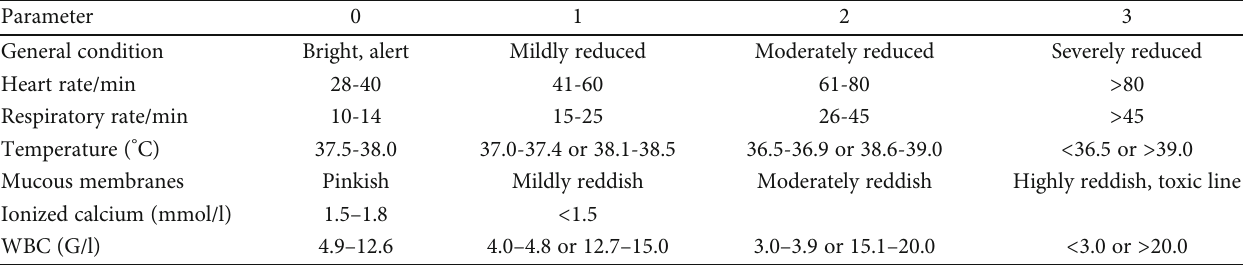
Table 1: Sepsis scoring modi fi ed from Breuer and Schusser [56]: classi fi cation in negative ( ≤ 6/19 points), questionable (7-9/19 points), or positive ( ≥ 10/19 points) for sepsis.